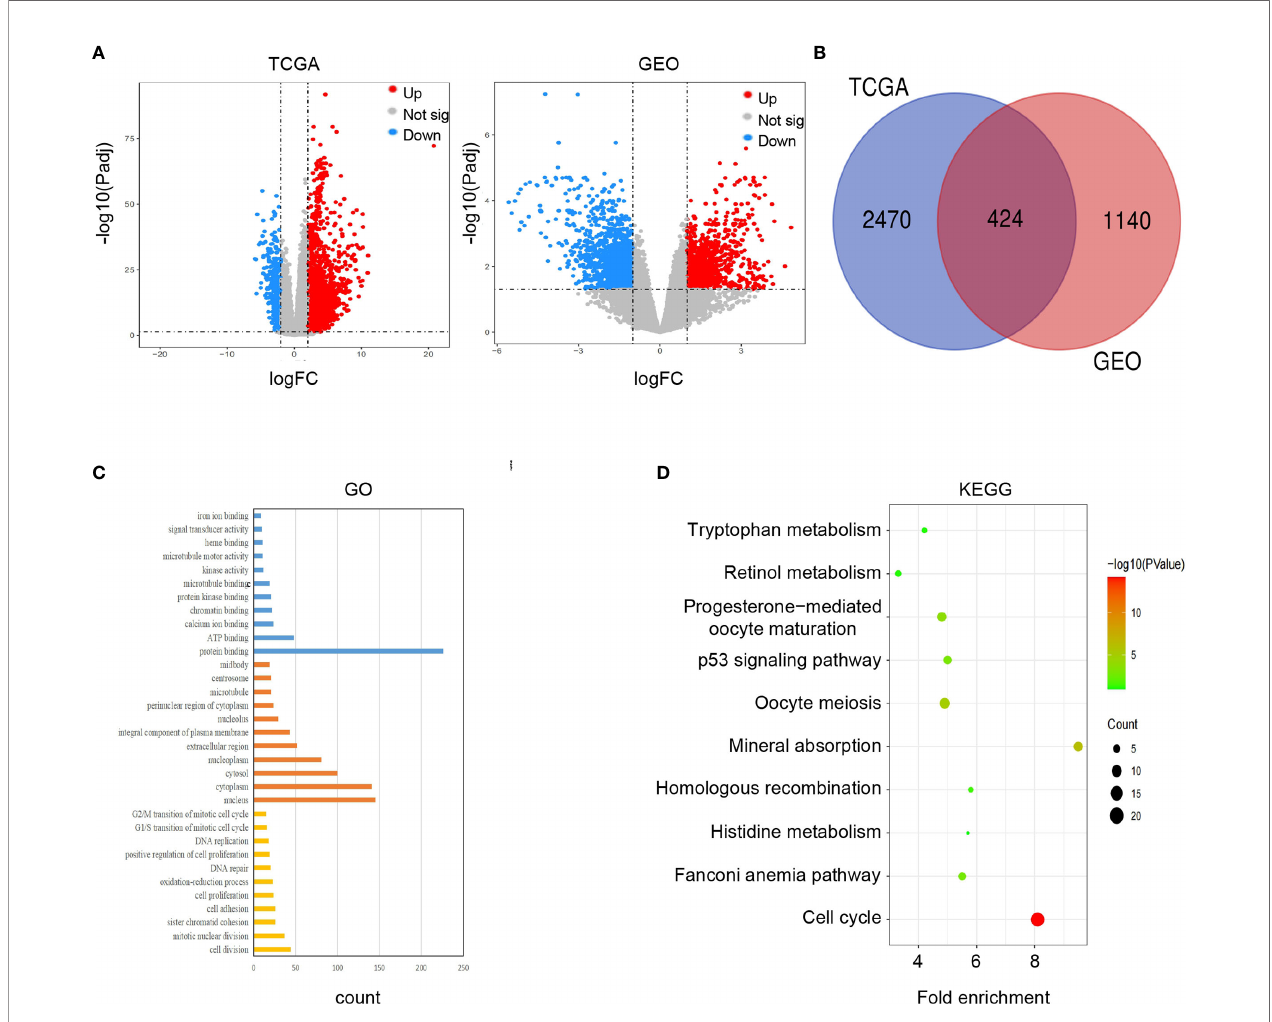
FIGURE 2 | Screening and enrichment analysis of DEGs. (A) Volcano plots showed differentially expressed genes (DEGs) in alcohol-related HCC from TCGA and GEO. (B) Venn diagram showed fi nal DEGs that are differentially expressed in both databases (TCGA and GEO). (C) GO analysis of DEGs. (D) KEGG analysis of